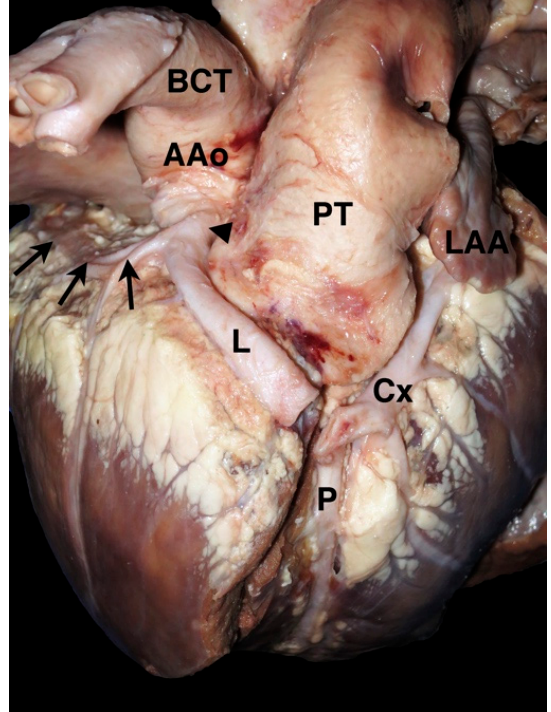
Figure 3. Photograph from a 2-month-old calf with double outlet right ventricle and a coronary artery anomaly. A single right coronary ostium (arrowhead) gives rise to the right coronary artery (arrows) as well as the left main coronary artery (L), which crosses cranial (prepulmonary) to the pulmonary trunk (PT) before dividing into the paraconal interventricular branch (P) and the circumflex branch (Cx). Note that the autopsy cut along the interventricular groove has transected the left coronary artery. AAo = ascending aorta, BCT = brachiocephalic trunk, LAA = left auricular appendage.